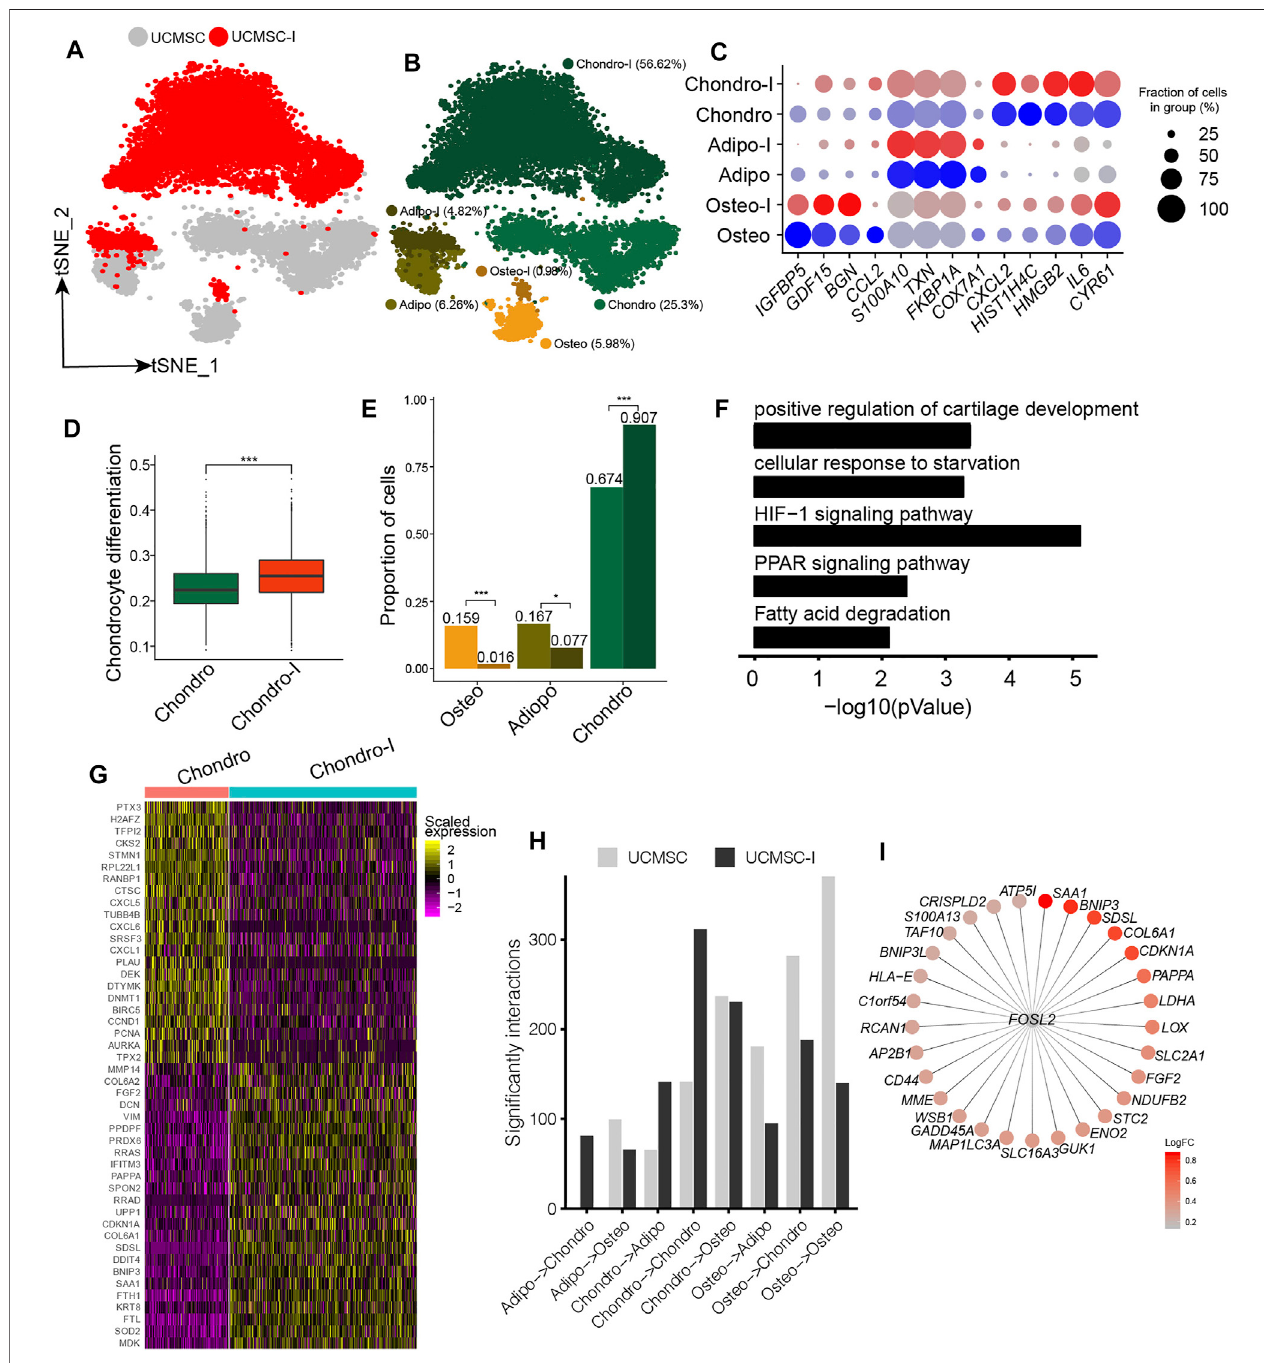
FIGURE 3 | Responseheterogeneity and dynamicsof MSCs to chondrogenesis induction and its underlying mechanisms. (A) . t-SNE projection of MSCs pre-and post- chondrogenesis induction, colored by non-induced UC-MSC (UC-MSCs) and chondrogenic-induced MSCs (UCMSC-I). (B) . t-SNE projection of MSCs pre-and post- chondrogenesis induction, colored bythe sixMSC subpopulations, namely chondro, osteo, adipo, chondro-I,osteo-I, and adipo-I. (C) .Dot plot ofthe expression level of lineage-speci fi c genes in MSC subpopulations pre-and post-chondrogenesis induction. (D) . Boxplot of chondrocyte differentiation scores of pre-induced chondro (Chondro) and chondrogenic-induced chondro (Chondro-I). Wilcoxon Rank Sum test, *** p < 0.001. (E) . Fractions of MSC subpopulation in MSCs and chondrogenic-induced MSCs. Fisher ’ s exact test, * p value < 0.01, *** p value < 0.001. (F) . The signi fi cantly enriched GO terms in chondro-I speci fi c genes compared to non-induced chondro. (G) . Heatmap of the most signi fi cantly differentially expressed genes between pro-and post-induced chondro. (H) . Bar plot of signi fi cant interactions between MSC subpopulations pairs in UC-MSCs and UCMSC-I. (I) . Bubble plot of FOSL2 and its target genes, with each target gene colored by log fold change between post-induced chondro and pre-induced chondro.